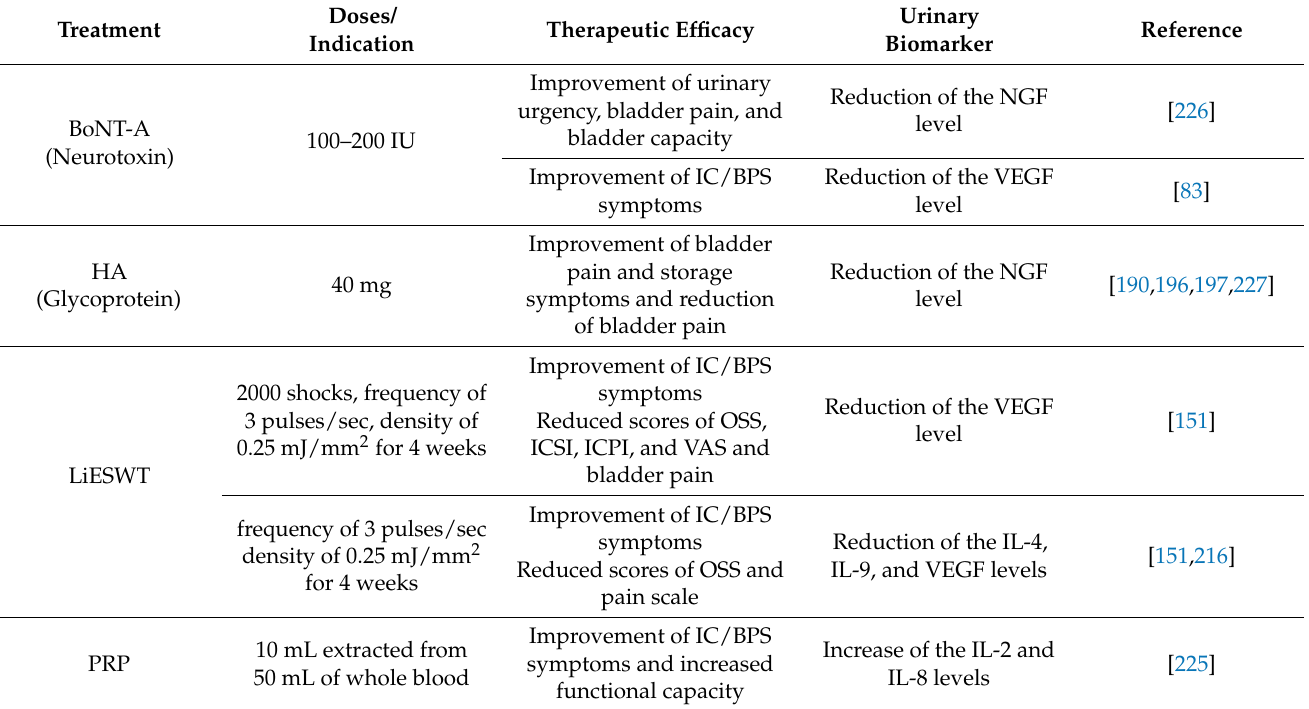
Table 4. Assessments of therapeutic outcomes with potential urinary biomarkers for IC/BPS after medical